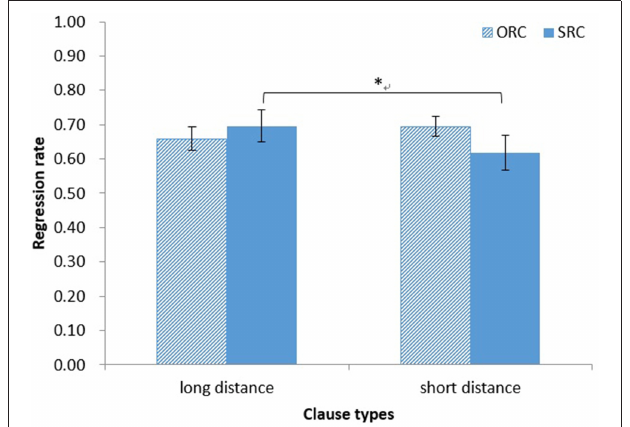
FIGURE 6 | Japanese group: regression-path durations for HNs in RCs. *** p < 0.001